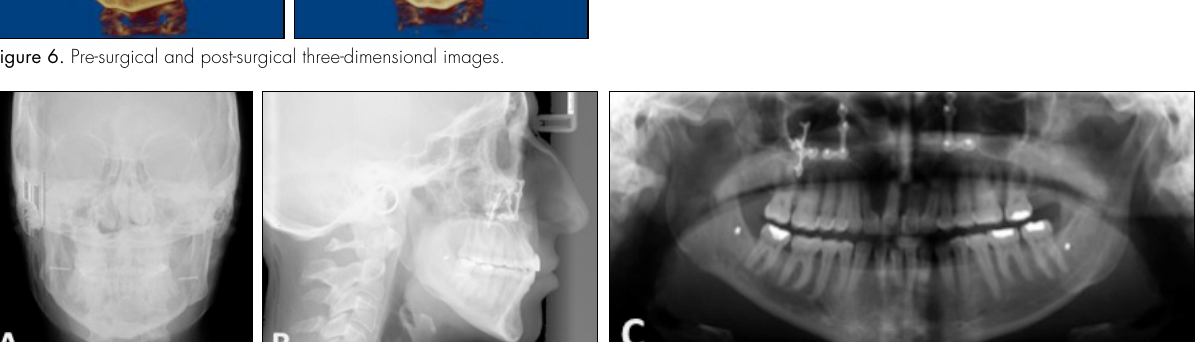
Figure 7. Post-treatment radiographs: A, posteroanterior cephalogram; B, lateral cephalogram; C, panoramic